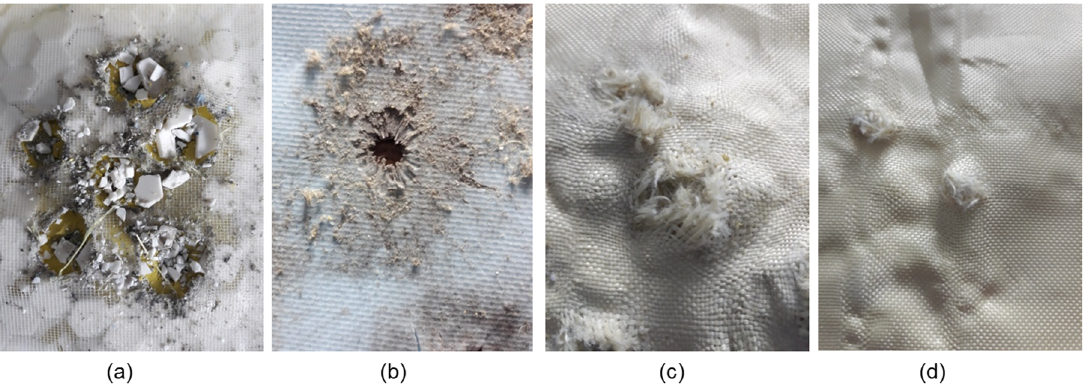
Figure 5. Components of the HSC composite after the ballistic test: ( a ) ceramics tiles—view from the impact side of the fragment; ( b ) silicone outer layer—view from the outlet side of the fragment; ( c ) Twaron ® CT612 soft ballistic armor—view from the impact side of the fragment; ( d ) Twaron ® CT612 soft ballistic armor—view from the outlet side of the fragment.